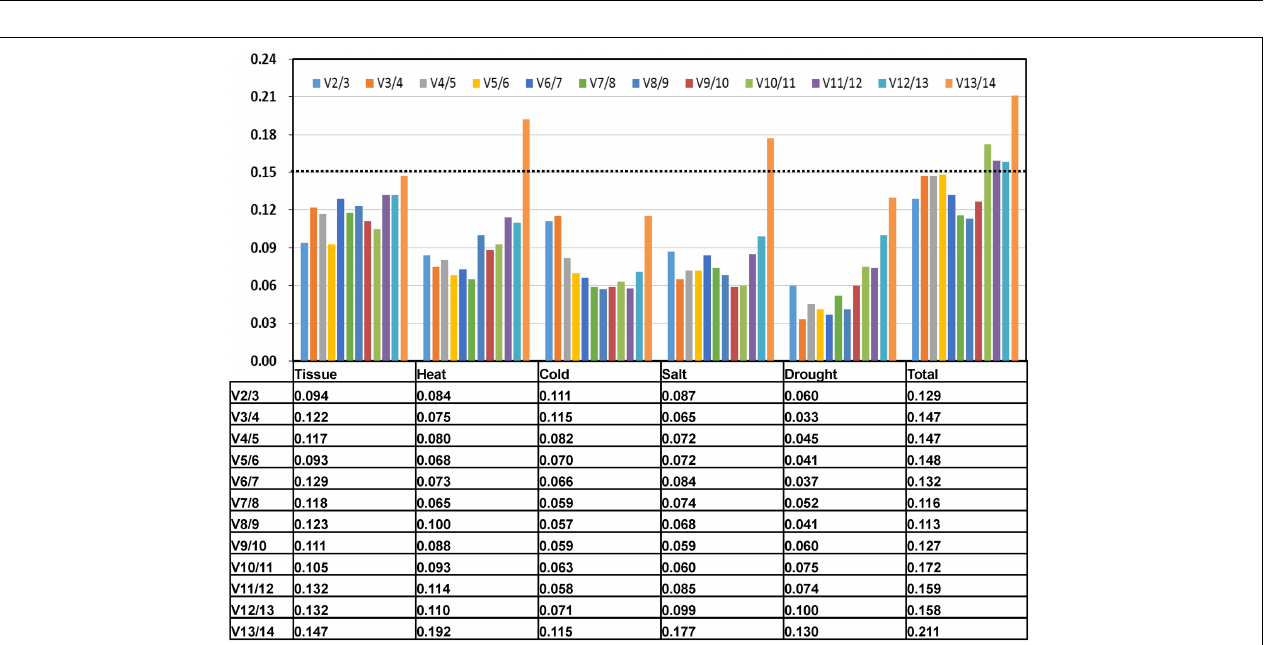
FIGURE 3 | PV to determine the optimal number of control genes for accurate normalization. The pairwise variation (Vn/Vn + 1) was analyzed between the NFn and NFn + 1 using geNorm software, where n is the number of genes involved in the NF.